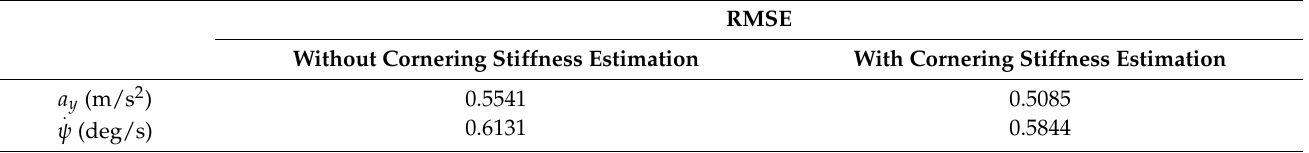
Table 8. RMSE of with and without cornering stiffness estimation in Case 3.